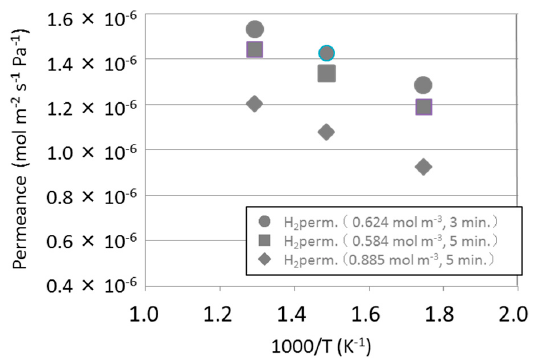
Figure 9. Influence of precursor concentration and CVD time to hydrogen permeance through HMDSO-derived membranes deposited on asymmetric substrates. Table 2. Influence of precursor concentration and CVD time to the selectivity (H 2 /N 2 ) of the HMDSO-derived membranes deposited on asymmetric substrates.